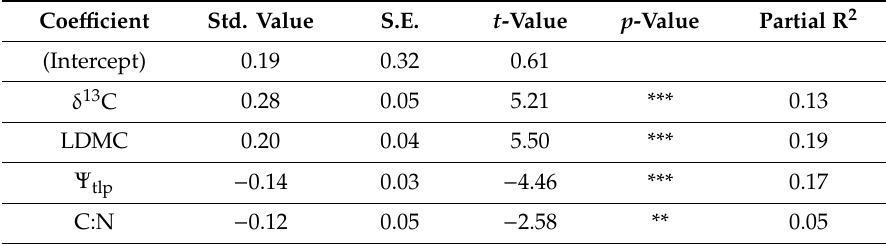
Table 4. Summary output of the model minimizing AICc along with the semi-partial R 2 calculated for each fixed e ff ect. Std. value, standardized coe ffi cient; S. E., standard errors. Coe ffi cient Std. Value S.E. t -Value p -Value Partial R